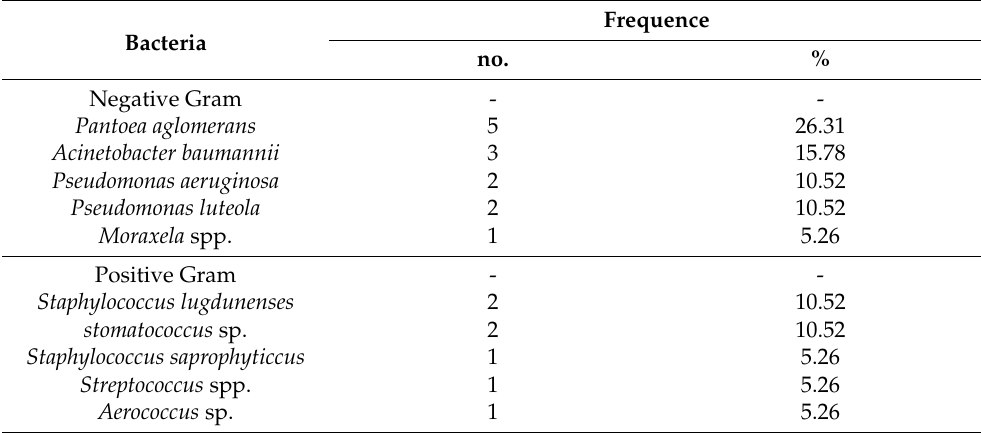
Table 1. Bacteria isolated from the surgical sites of cats subjected to ovariosalpingohysterectomy